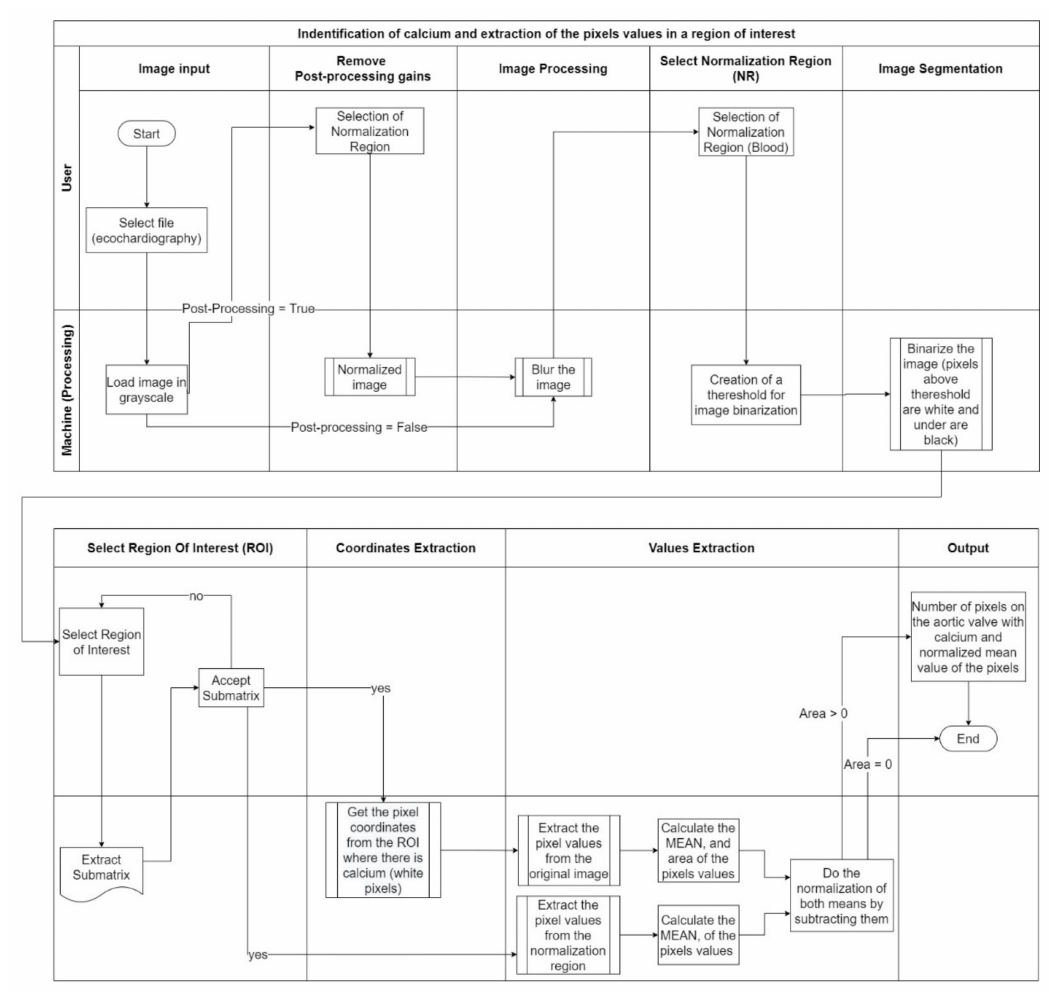
Figure 14. Process Description.